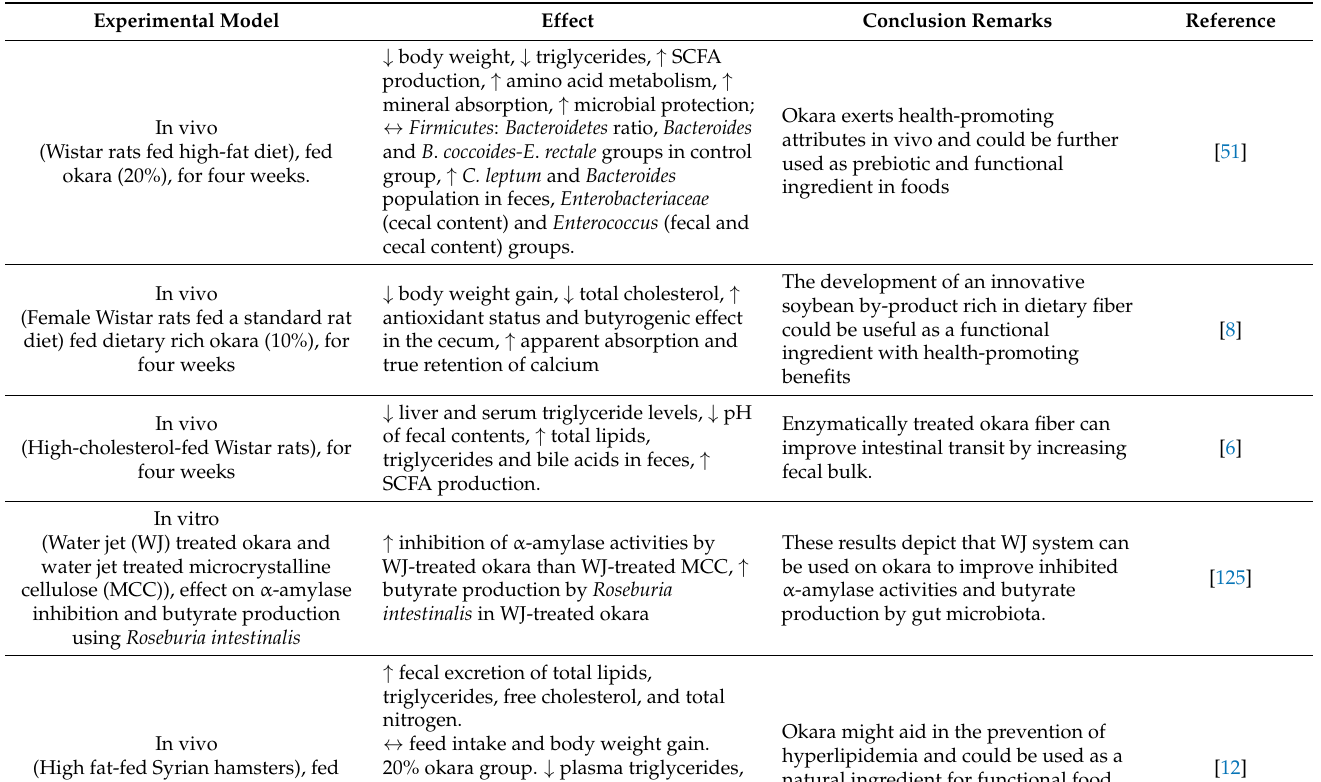
Table 3. Effect of okara supplementation on nutrition (in vivo/in